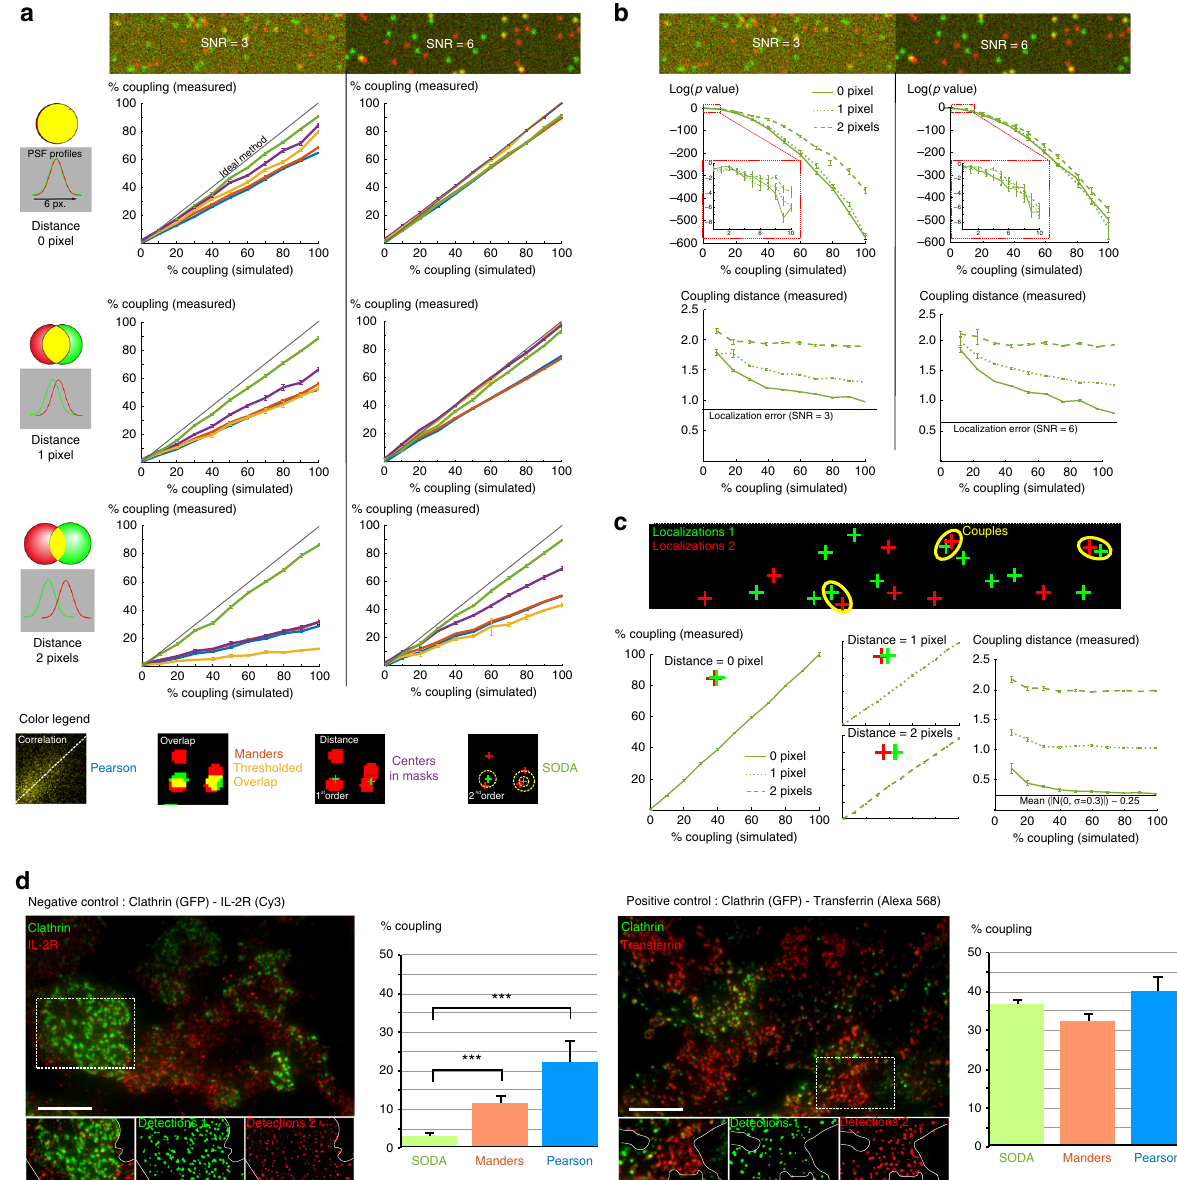
Fig. 2 Validation of SODA a Synthetic fl uorescent images with different SNR and coupling parameters are generated (Material and Methods). SODA is compared with main coupling indexes (see Table 1): Pearson correlation coef fi cient (PCC), Manders Overlap Coef fi cient (MOC), Thresholded Overlap (TO) with T = 0.5 (i.e., percentage of (red) spots whose more than 50% of the mask overlaps with a (green) mask 8 ) and Mass-centre in Masks (MM) (error bars = ± 1 standard error of the mean (s.e.m.), 10 synthetic images per condition). b (Log) p -value (Material and Methods) and mean coupling distance (Eq. 3) are computed with SODA for increasing coupling distances ( d = 0 pixels in solid line, d = 1 in dotted line and d = 2 in dashed line). (Log) p - values for coupling percentages between 0 and 10% are zoomed (red dashed box). Error bars = ± 1 s.e.m. c Testing SODA with point process (localisations) Monte-Carlo simulations (10 simulations per distance and coupling index). n 1 = 100 (red) points ( = localisations) and n 2 = n 1 = 100 (green) points are distributed in a 256 × 256 square (Material and Methods). The expected mean distance ≈ 0.25 for a Gaussian point process with mean 0 and s.d. 0.3 (Material and Methods) is highlighted with a continuous black line. Error bars = ± 1 s.e.m. d Analysis of the coupling between two endocytic cargos (IL-2R or Tf) and Clathrin (Hep2beta Clathrin-GFP). IL-2R, Tf (red) and Clathrin (green) molecules are labelled with fl uorescent probes and observed in total internal re fl ection fl uorescence (TIRF) microscopy. Fluorescent spots are automatically extracted using Spot detector in Icy. Cell boundaries are highlighted with a white solid line. The coupling index between IL-2R and Clathrin (negative control) estimated with SODA is compared with Pearson (PCC) and Manders (MOC) coef fi cients. Note that SODA does not detect coupling (percentage = 2.41 ± 0.6% (s.e.m.) ( p -value = 0.085) between clathrin (13 cells, 5124 spots) and IL-2R (6145 spots), contrary to Manders (12.6 ± 1.04%, p -value with pixel scrambling = 0.0012) and Pearson correlation analysis (21.9 ± 5.97%, p -value with pixel scrambling = 2.8 10 − 6 ). In the positive control, the three co-localisation index measure an important, comparable and statistically relevant coupling between Tf (15 cells, 8407 spots) and clathrin-coated structures (9623 spots) (SODA: 36.5 ± 1.49%, p -value = 1.54 10 − 16 ; Manders: 31.7 ± 2.38%, p -value < 10 − 16 and Pearson: 40.8 ± 3.03%, p -value < 10 − 16 ). Error bars = 95% c.i. Scale bar = 10 μ